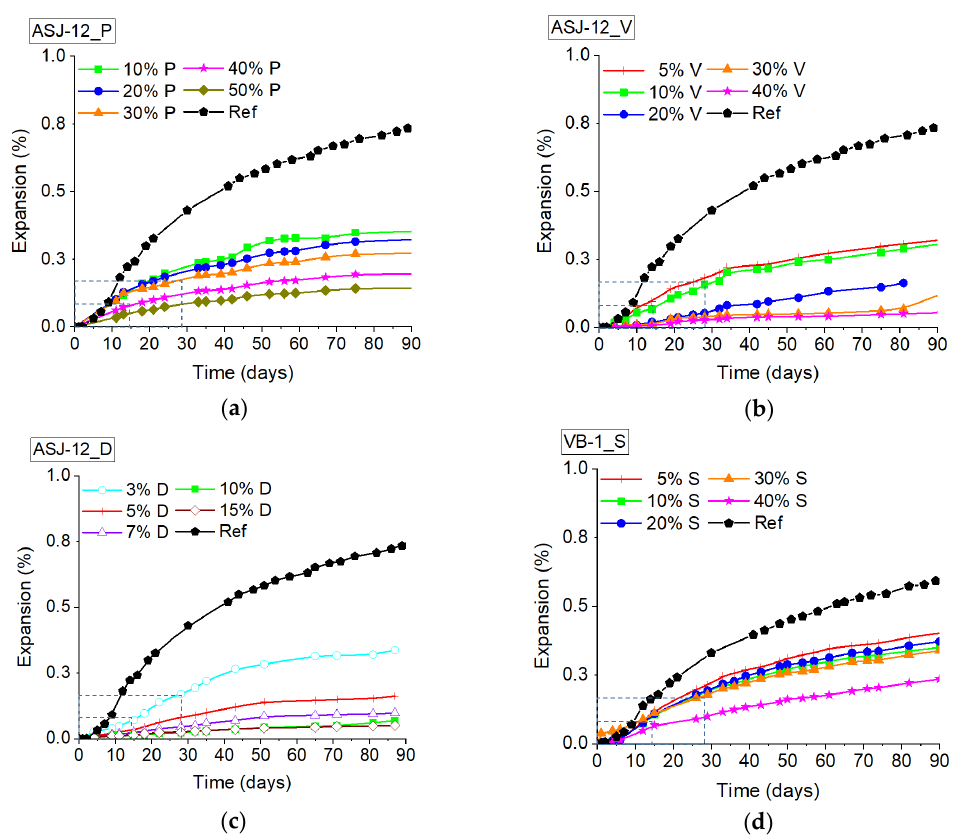
Figure 8. Alkali-silica mitigation by pozzolanic additions in mortars made with the reactive siliceous pebble, ASJ_12, and four additions mixed in four percentages of 20%, 30%, 40% and 50%: ( a ) natural pozzolan, P; ( b ) siliceous coal fly ash, V; ( c ) silica fume, D; ( d ) blast-furnace slag, S. The average expansions, of three mortar bars for each pozzolanic material, for 90 days of